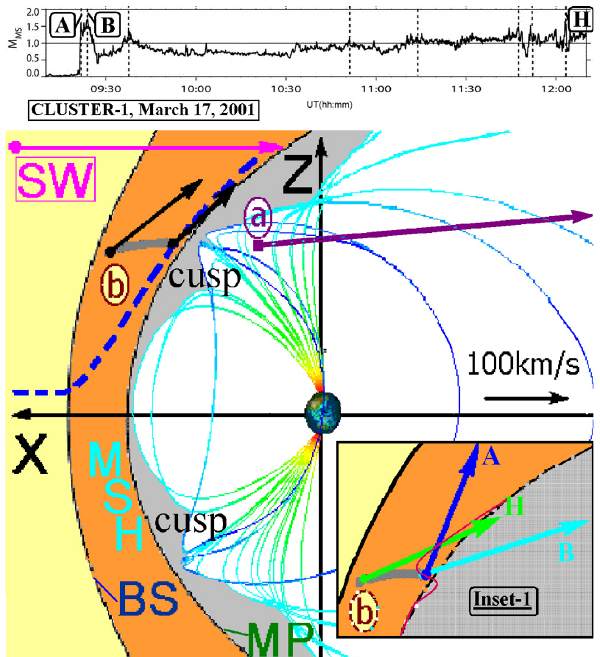
Fig. 2. Top panel: plot of the Cluster 1 magnetosonic Mach num- ber M MS for a MSH traversal on 17 March 2001 (see details in text and in Amata et al., 2011). Bottom panel: scheme of the SPS inter- action with the magnetosphere (GSE frame, all for 17 March 2001 except the arrow marked by circled “a”). From left to right: SW, BS, MSH, MP and magnetic field lines in the magnetosphere calculated through OVT (http://ovt.irfu.se) using the SW dynamic pressure and IMF at 11:00UT on 17 March 2001. The background flow veloci- ties in the MSH are marked by “b” and black arrows in the top left part; the blue dashed line shows a plasma streamline; the thick grey line is the Cluster orbit; the violet arrow marked “SW” shows the average SW velocity. The dark violet arrow marked “a” displays the velocity vector for the SPS at 06:33UT on 7 February 2001 (Clus- ter 1), marked by a grey arrow in Fig. 3. Inset 1 repeats a portion of the main figure: instead of quiet MSH velocities, streamline and magnetic field lines, the inset shows velocity vectors for the “A”, “B” and “H” SPS’s and the distorted MP (see the thin red line) from Amata et al.